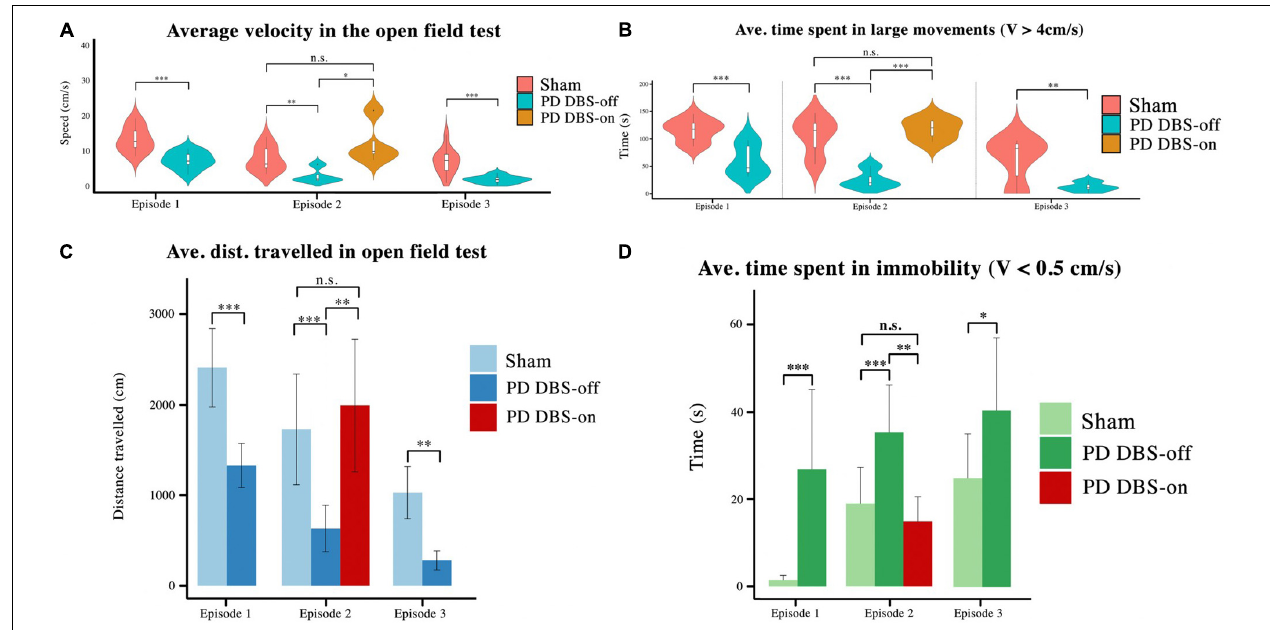
FIGURE 7 | Four behavioral features of the OF test were analyzed using the animals’ tracking data. (A) The average velocity, (B) time spent in large movements, (C) distance traveled, (D) and the time spent in immobility were selected as variables to compare across groups. It is shown here that unstimulated animals exhibit lower velocity, distance traveled, and time spent in large movements than stimulated or healthy animals, and instead spend more time in immobility. However, the subgroup that received DBS exhibits significant exploratory improvements and a significant reduction in their immobility spells. Level of significance: (* p < 0.05, ** p < 0.01, *** p < 0.001, and n.s. stands for not significant). Figure adapted from Mottaghi